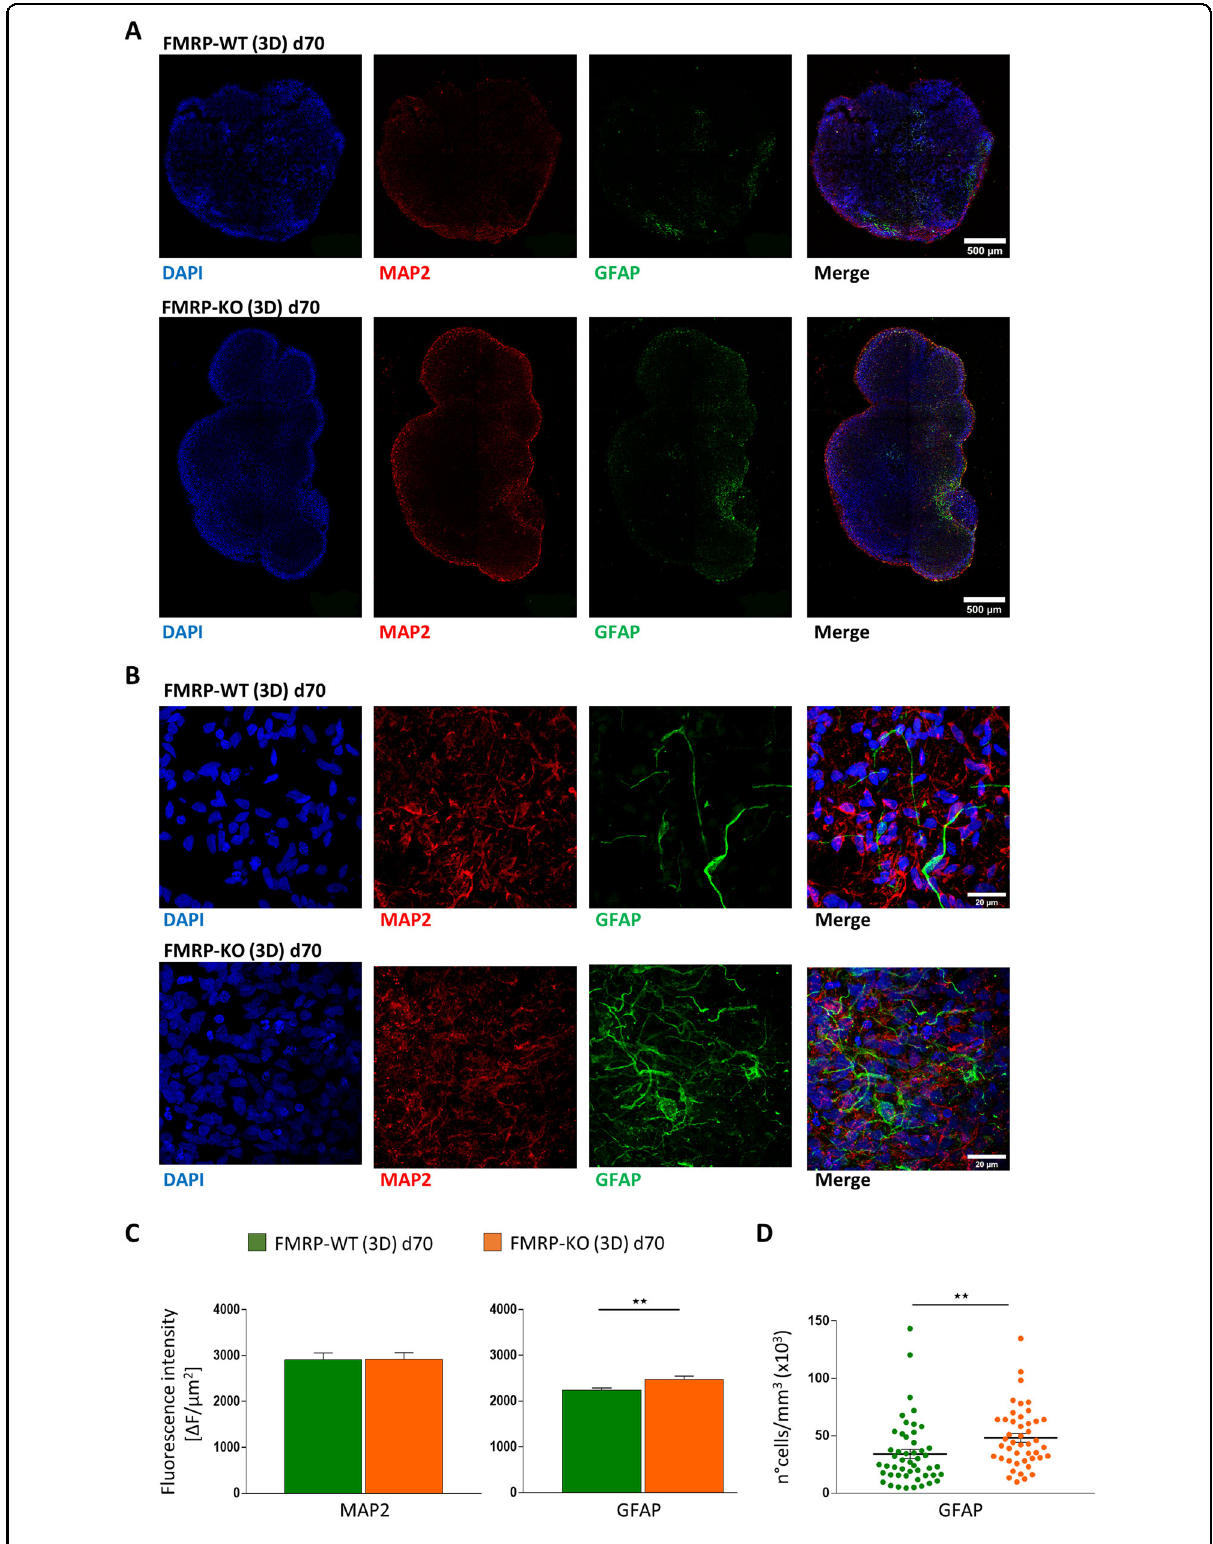
Fig. 8 (See legend on next